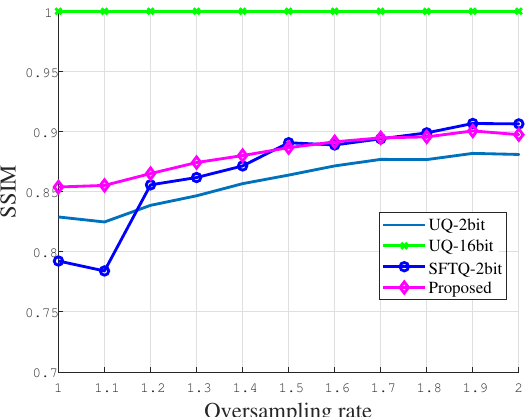
Figure 16. SSIMs of imageries with different quantization